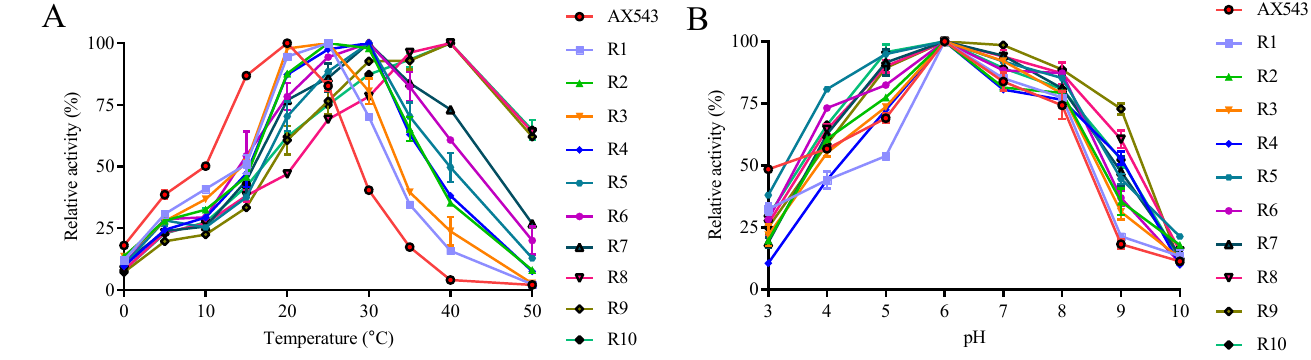
Figure 9. The effects of temperature ( A ) and pH ( B ) on AX543 and its chimeras.